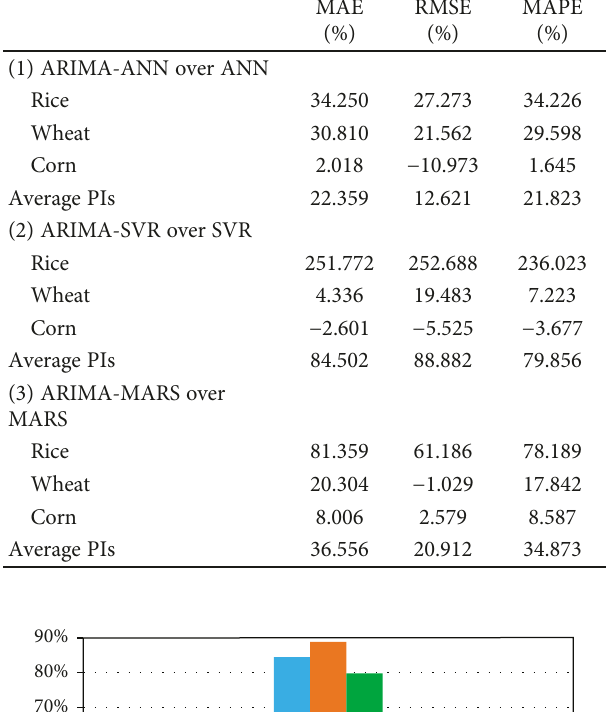
Figure 7: Forecasts of rice prices versus actual observations for the 12 testing records (with the use of ARIMA, SVR ARIMA-SVR models).